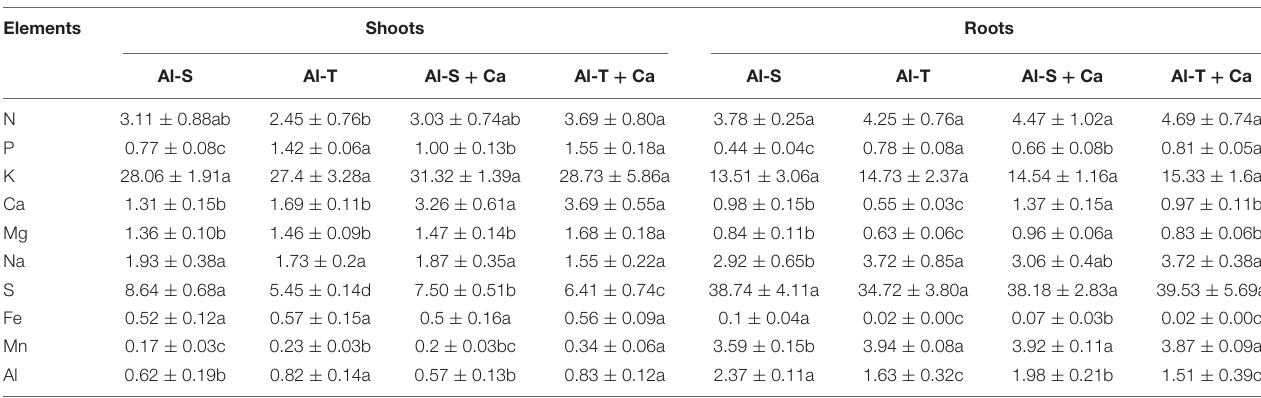
TABLE 1 | Mineral element contents of rice plants (g · kg − 1